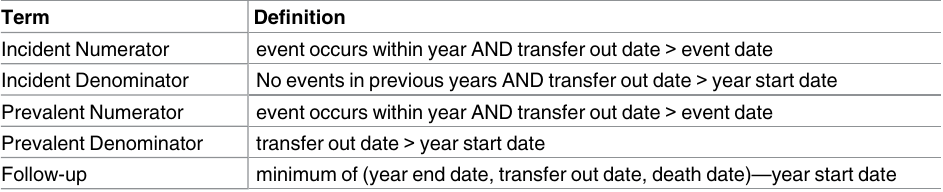
Table 1. Definitions of incidence and prevalence